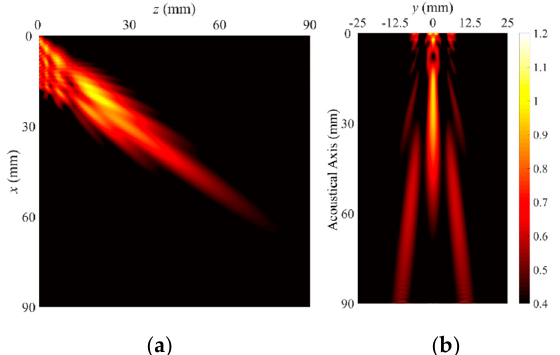
Figure 6. Radiation patterns and beam profiles of leaky A(0,1) mode Lamb wave, ( a ) vertical beam profile, and ( b ) lateral beam profile.